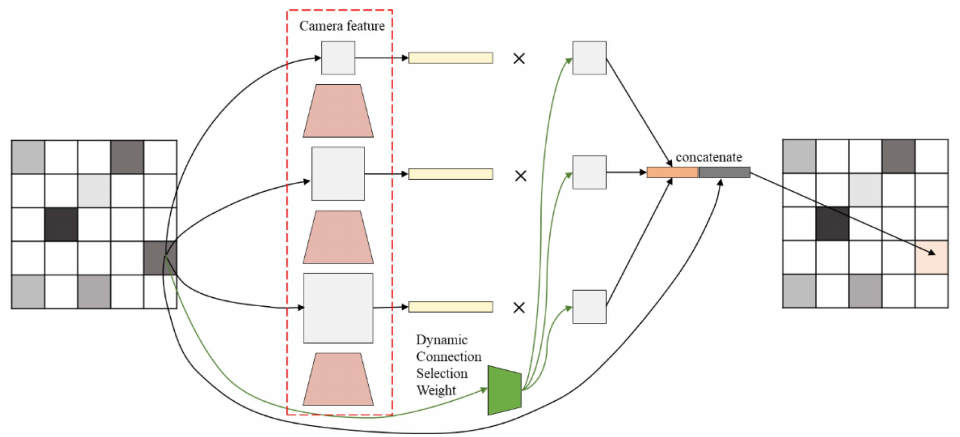
Figure 10. Dynamic linkage